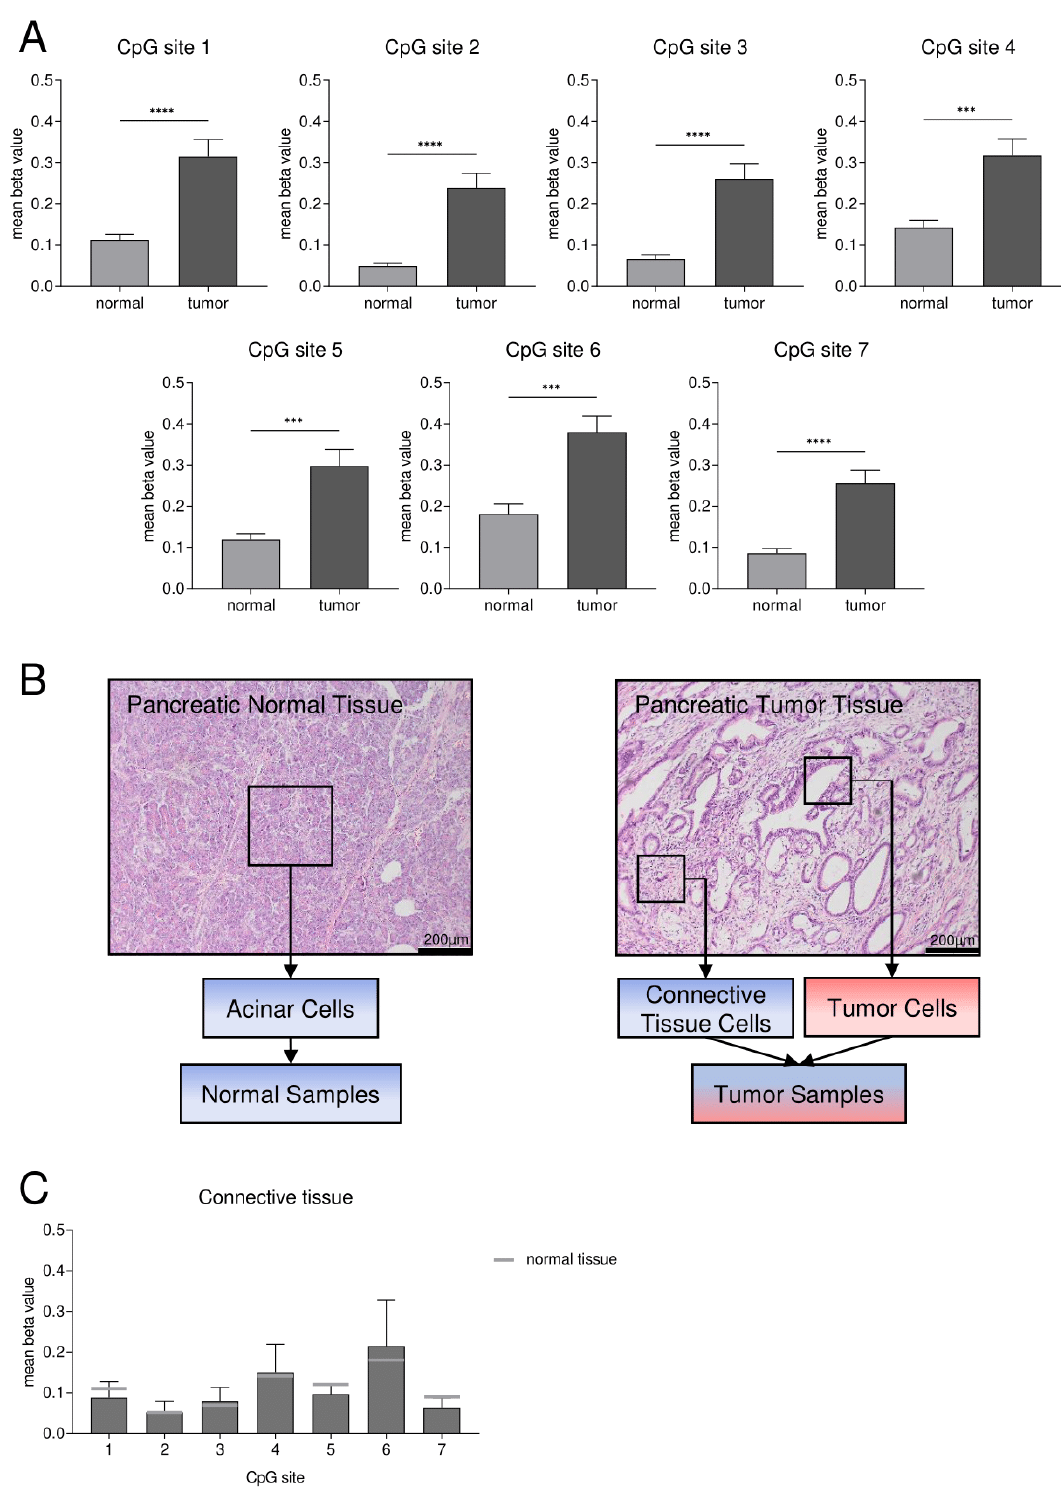
Figure 3. Abundant SFRP1 CGI2 DNA methylation in pancreatic cancer patients compared to normal acinar tissue. ( A ) Mean methylation status of seven specific CpG sites (CpG site 1–7, Figure 1C) is significantly higher in pancreatic ductal adenocarcinoma (tumor) ( n = 28) vs. normal tissue ( n = 28) (Tukey’s test for CpGs 1, 2, 4, 5, 7, Dunn’s test for CpGs 3, 6, *** p < 0.001, **** p < 0.0001). Since the three groups of normal, tumor and additionally metastases tissues were compared, statistical analysis was performed as multiple comparison. ( B ) HE-stained microscopic images of pancreatic